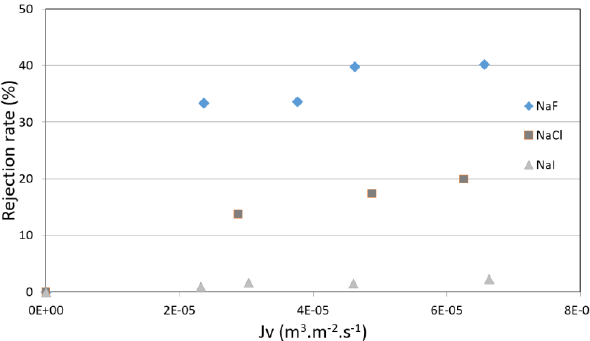
Figure 5. Rejection rate of pure salt-water solution (NaF, NaCl or NaI—5 × 10 −3 M) vs. permeation flux obtained with membrane 2.